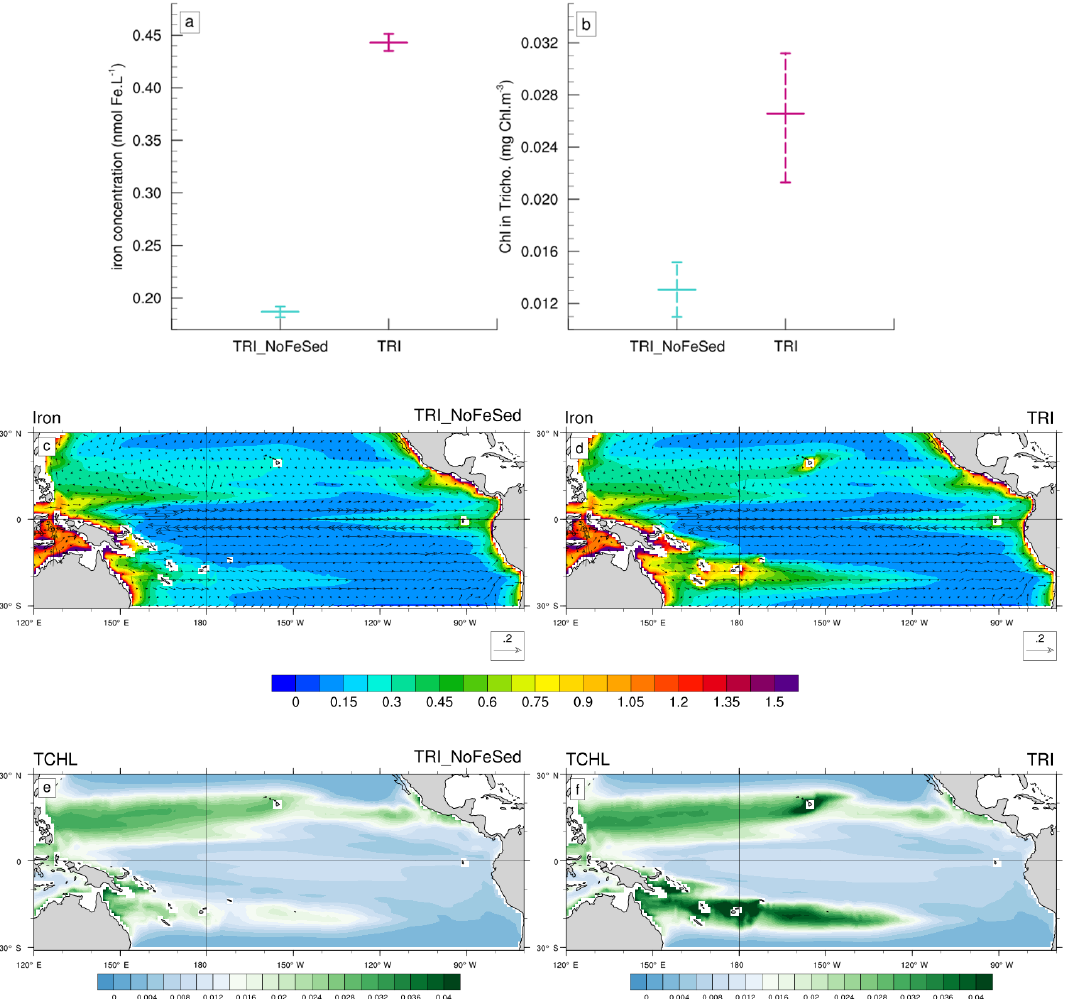
Figure 9. (a, b) Minimum, mean and maximum in the South box (Fig. 1c) of (a) the iron concentrations (in nmolFeL − 1 ), and (b) of the chlorophyll concentrations of Trichodesmium (in mgChlm − 3 ). (c, d, e, f) Annual mean iron concentrations (shading; in nmolFeL − 1 ) and current velocities (vectors; in ms − 1 ) for (c) the TRI_NoFeSed simulation and (d) the TRI simulation. Annual mean chlorophyll concen- trations of Trichodesmium (mgChlm − 3 ) for (e) the TRI_NoFeSed simulation and (f) the TRI simulation. The concentrations have been averaged over the top 100m of the ocean. The current velocities are identical on the panels (a) and (b)